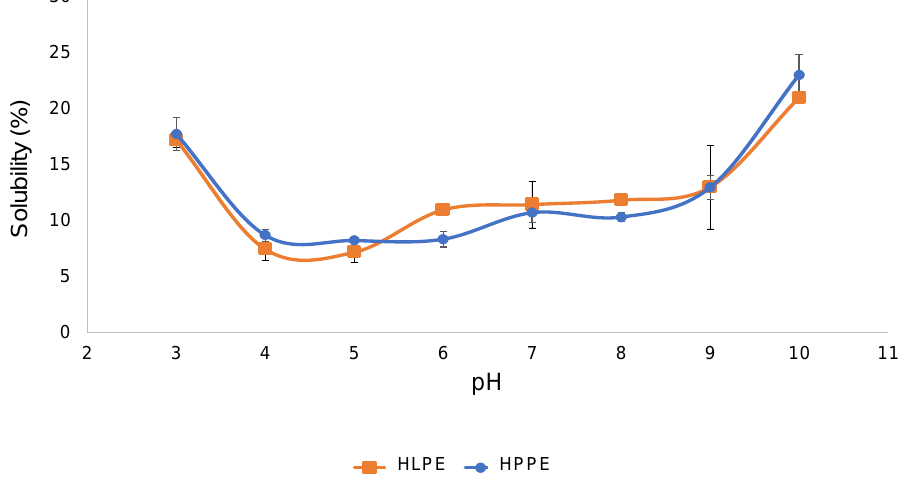
Figure 5. The solubility of the Huhu larvae and pupae protein concentrates at various pH levels .